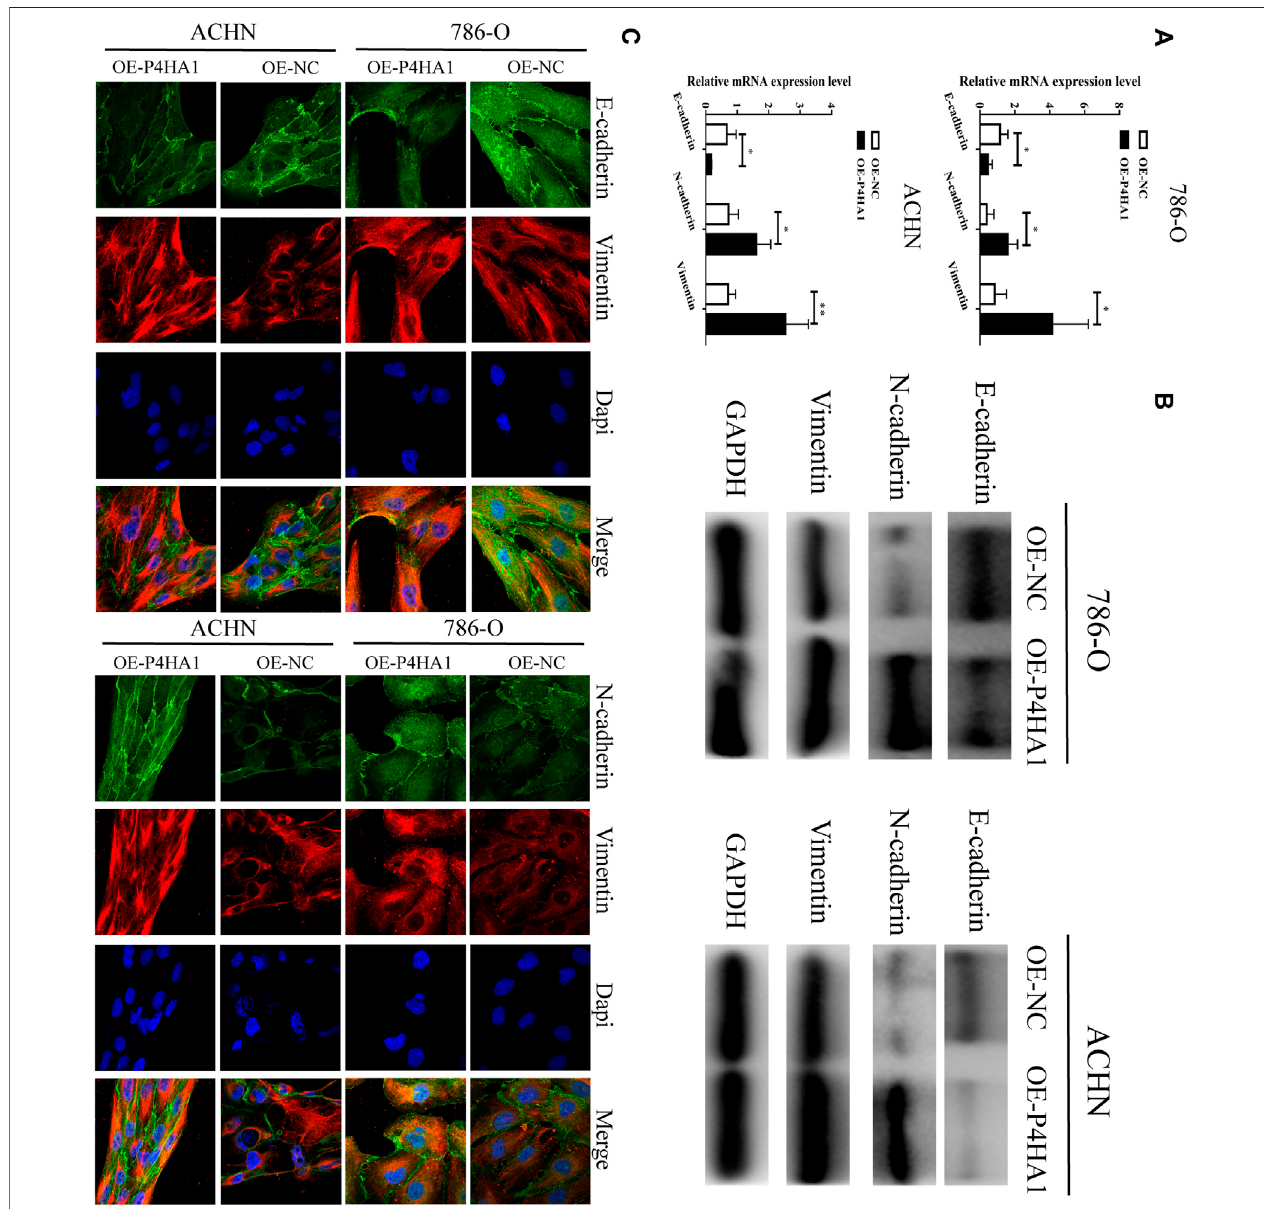
FIGURE 8 | P4HA1 could regulate (epithelial – mesenchymal transformation) the EMT regulatory axis. (A) QRT-PCR assay was conducted to detect the mRNA expression ofEMT-related genes(E-cadherin, N-cadherin, and Vimentin). (B) Westernblotassaywasconductedtodetectthe protein expression ofEMT-related genes (E-cadherin, N-cadherin, and Vimentin). (C) Immuno fl uorescence confocal was conducted to detect the expression of EMT-related genes.